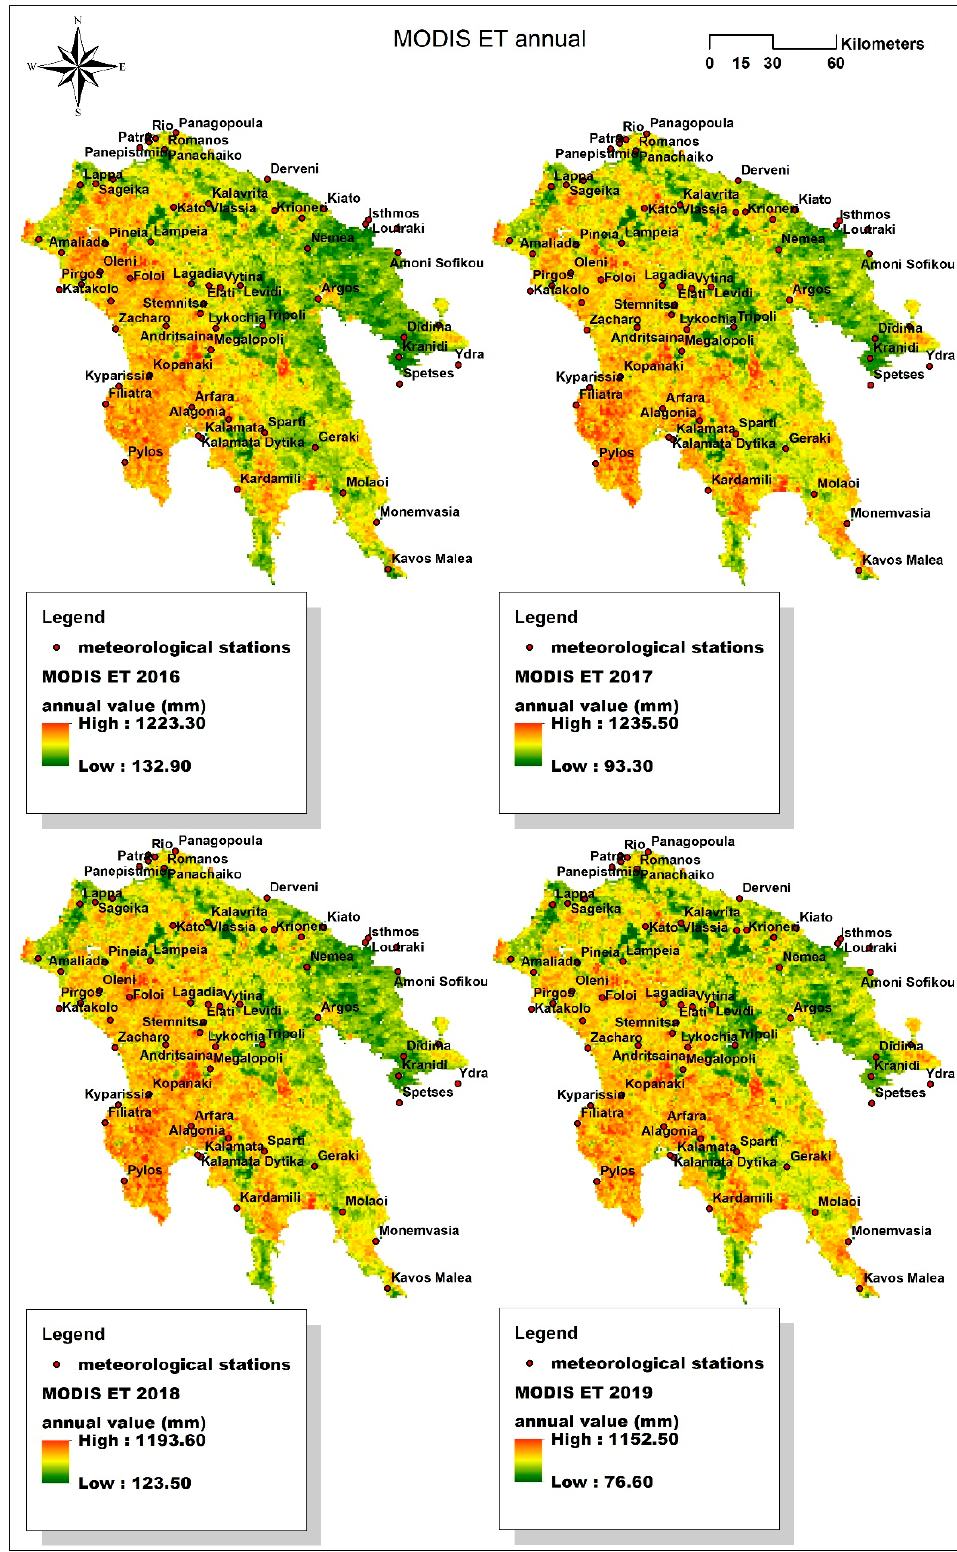
Figure 7. Annual ET (in mm) from MODIS 8 ‐ day composites for 2016–2019.